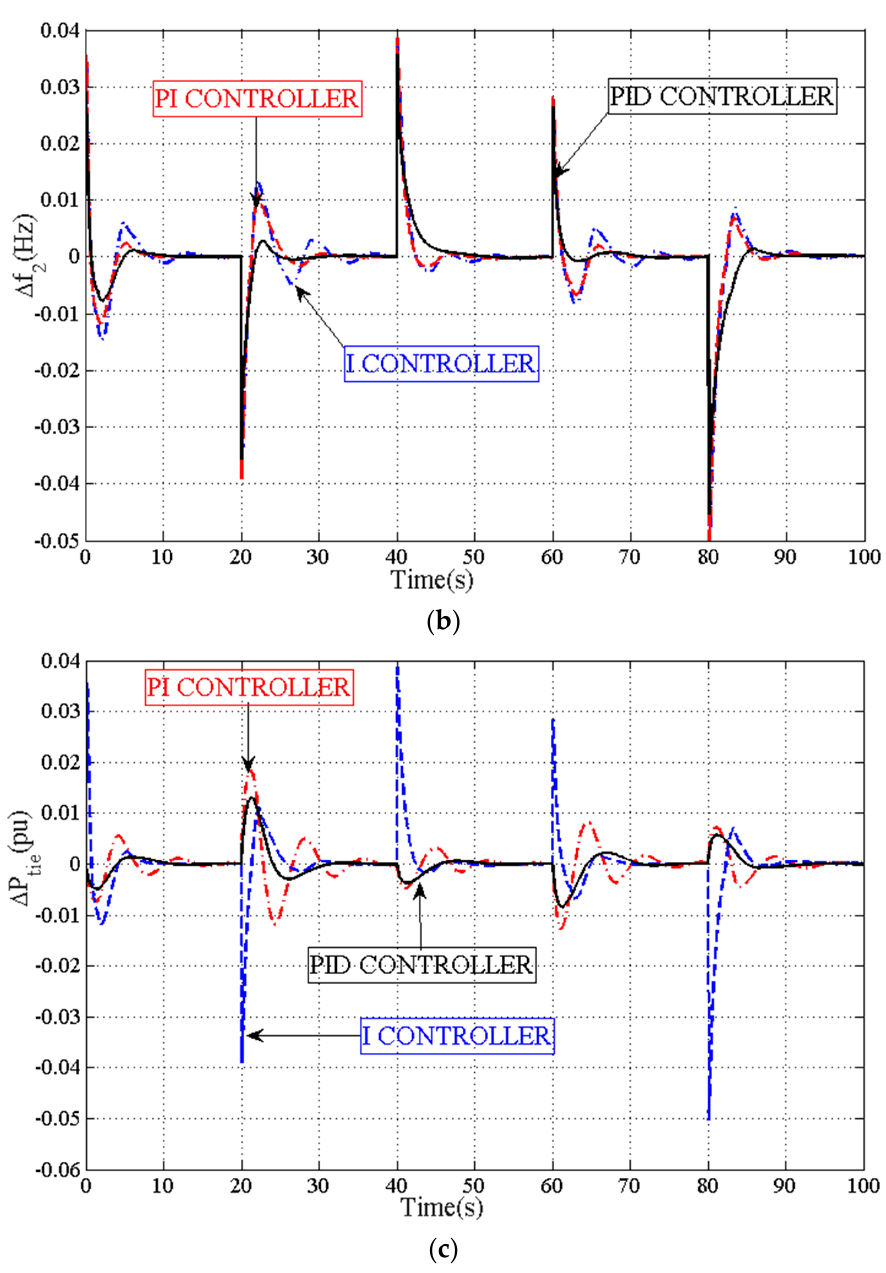
Figure 12. System responses for randomized nature disturbance. ( a ) ∆ f 1 ; ( b ) ∆ f 2 ; and ( c ) ∆ P tie